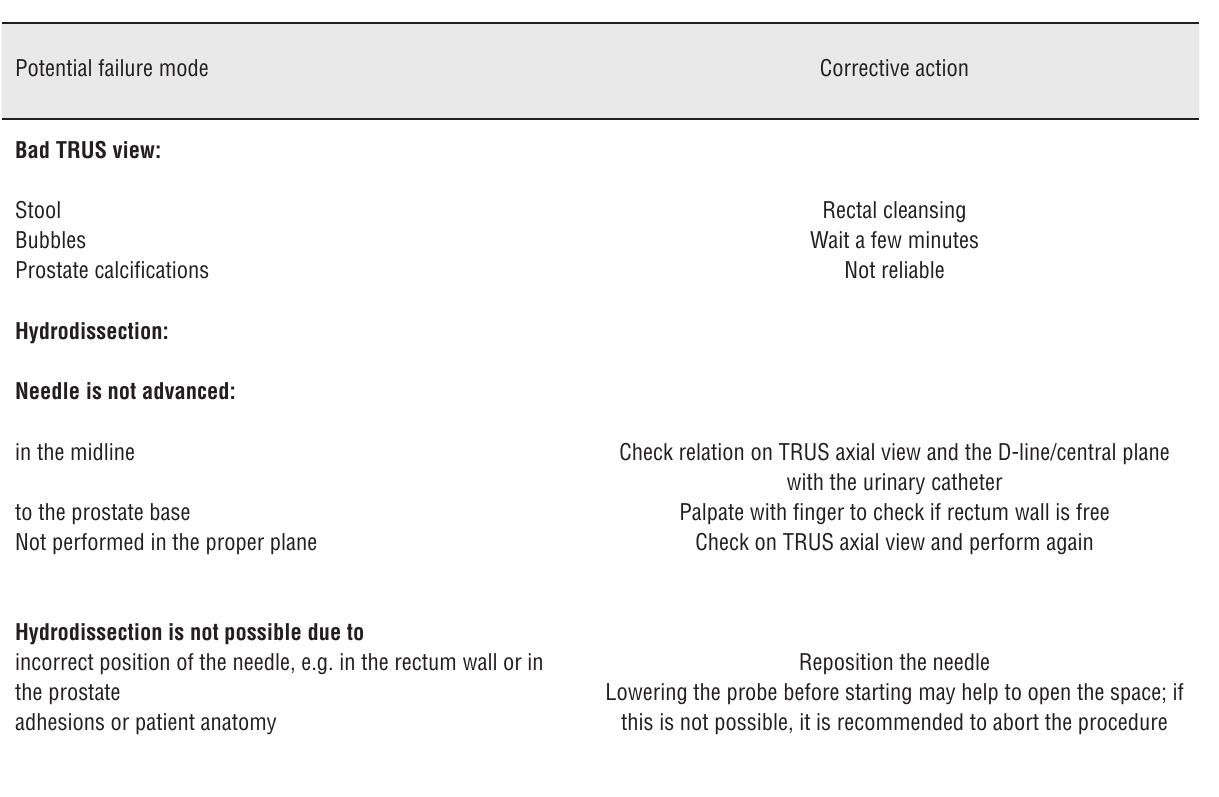
Table 1 - List of hazards adapted to RBI implantation and corrective actions.